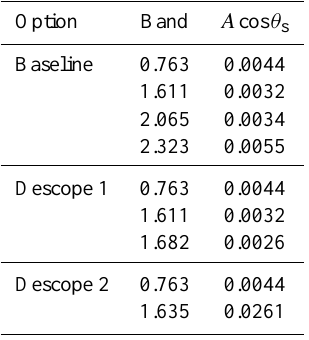
Fig. 3. Optical layout for geoCARB. The primary beam splitter di- vides the long- and short-wave spectrometer arms. Each Littrow spectrometer feeds two separate focal planes. Table 3. Values of A cos θ s such that N 2 that the shot noise limit is reached for very low levels of illumina- tion.